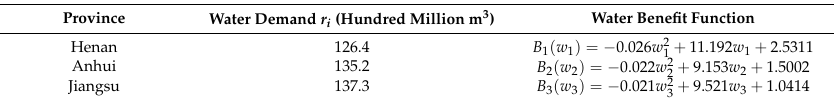
Table 1. The water benefit function of each province. Please confirm if the lowercase is correct? Please check all cases like this in all